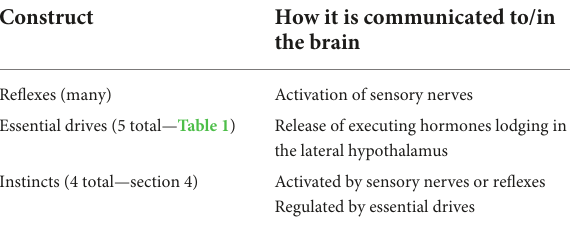
TABLE 2 Interrelationship of reflex, drive and